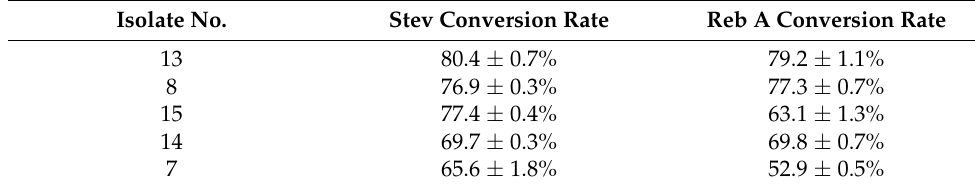
Table 2. Conversion rate of Stev and Reb A.